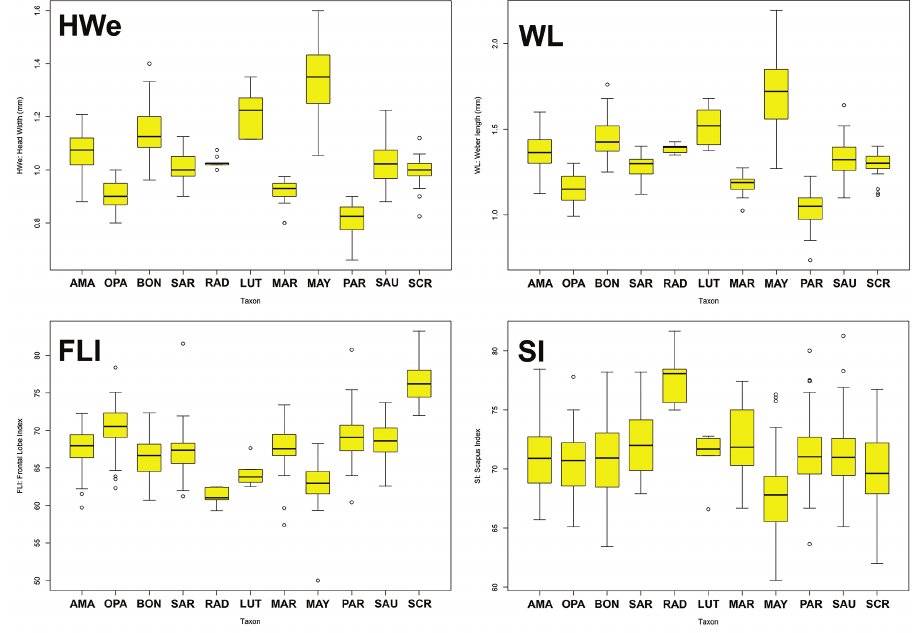
Figure 3. Box plots for morphological variables. HWe Head width including the eyes WL Weber’s